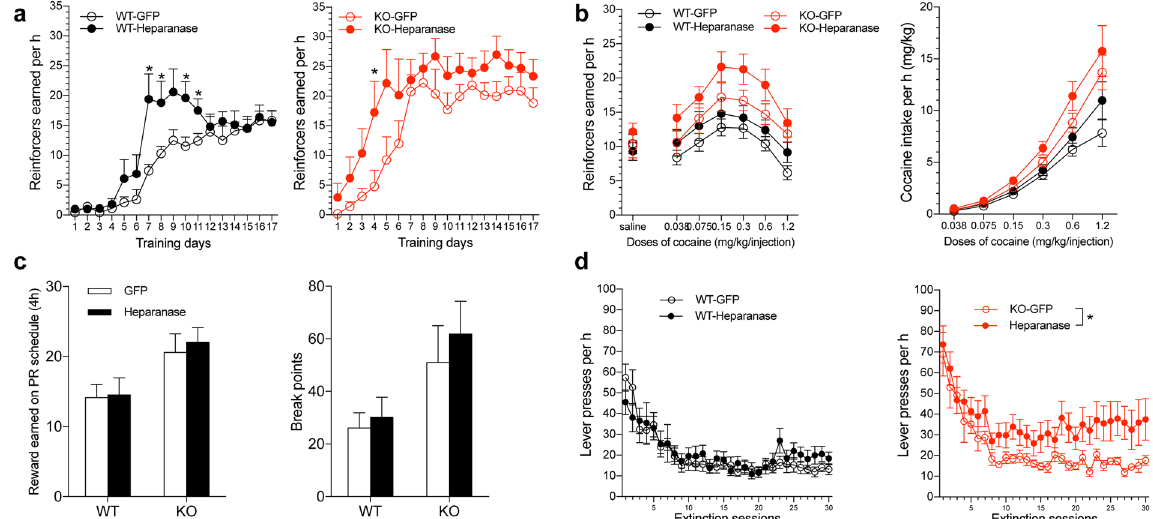
Figure 3. Delivery of recombinant AAV-heparanase in the LH facilitates the acquisition of cocaine self- administration in syndecan-3 knockout (KO) and wildtype (WT) mice and induces greater resistance to extinction in syndecan-3 KO mice. ( a ) Intra-LH heparanase-AAV virus facilitated the acquisition of cocaine self-administration in both wildtype (left) and syndecan-3 knockout (right) mice. The two-way repeated- measures ANOVA revealed significant main effects of repeated training ( F 16,288 = 26.51, p < 0.0001) and heparanase-AAV administration ( F 1,288 = 4.613, p = 0.046) and a significant interaction between these two factors ( F 16,288 = 2.316, p = 0.003) in wildtype mice. Similarly, in knockout mice, there were significant main effects of repeated training ( F 16,336 = 15.43, p < 0.0001) and heparanase-AAV administration ( F 1,336 = 4.982, p = 0.037). The post hoc tests revealed significant differences on several training days between the corresponding groups ( * P < 0.05, WT-GFP, n = 10; WT-Heparanase, n = 10; KO-GFP, n = 12; KO-Heparanase, n = 11). ( b , c